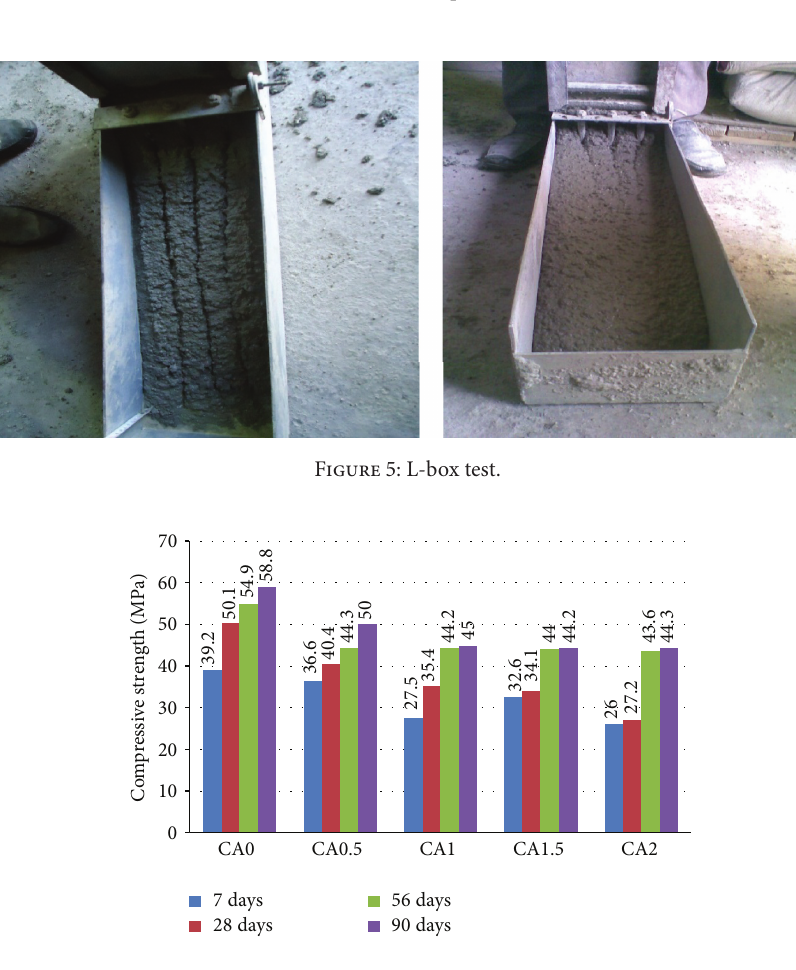
Figure 6: Compressive